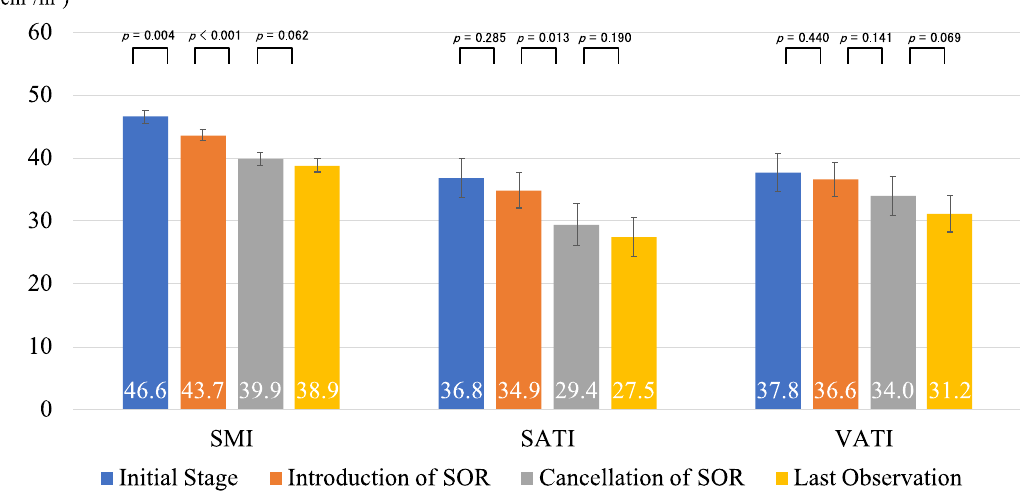
Figure 1. The values of skeletal muscle index (SMI), subcutaneous adipose tissue index (SATI), and visceral adipose tissue index (VATI) at the initial stage, introduction of sorafenib (SOR), cancellation of SOR, and last observation time. Error bars represent standard errors.